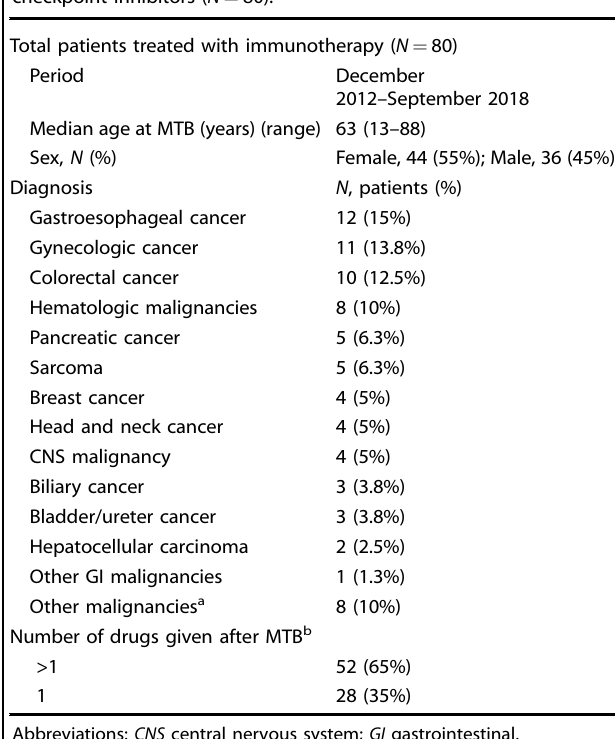
Table 1. Baseline demographics of patients presented at the Molecular Tumor Board (MTB) and subsequently treated with immune checkpoint inhibitors ( N =